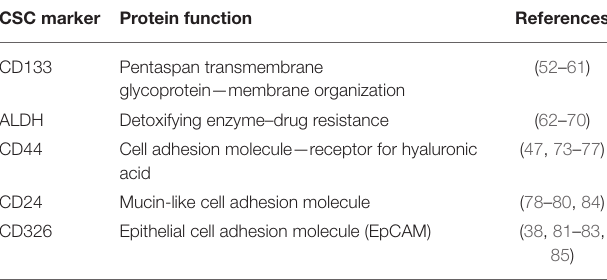
TABLE 1 | List of some putative CSC